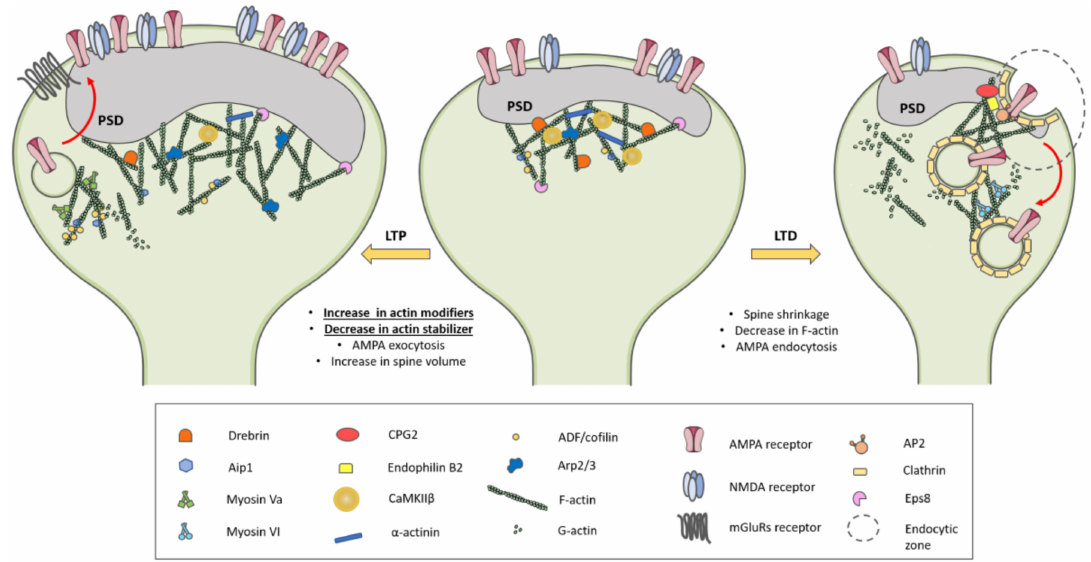
Figure 2. Dendritic spine actin cytoskeleton dynamics in activity-dependent synaptic